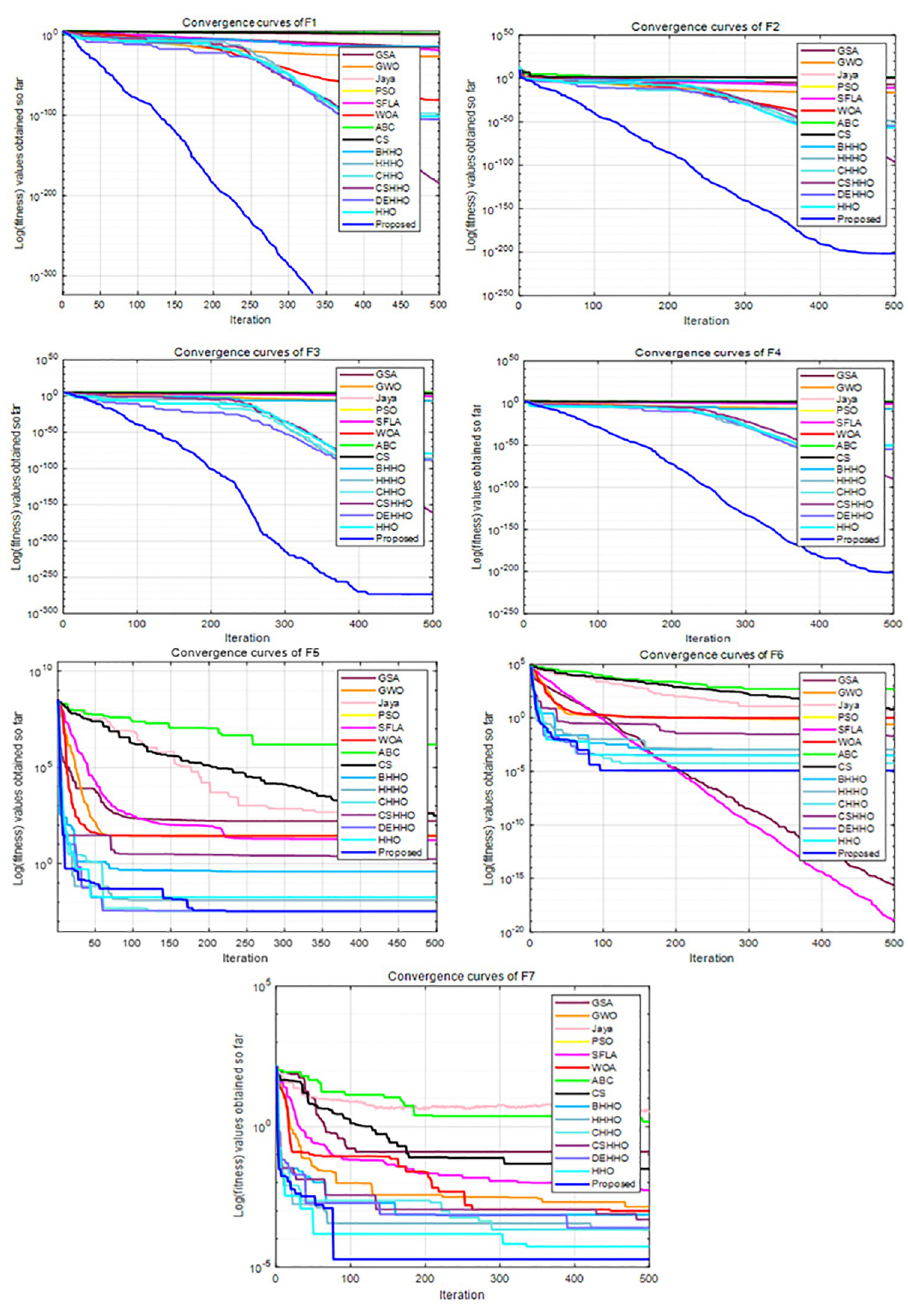
Fig 5. Convergence curves of